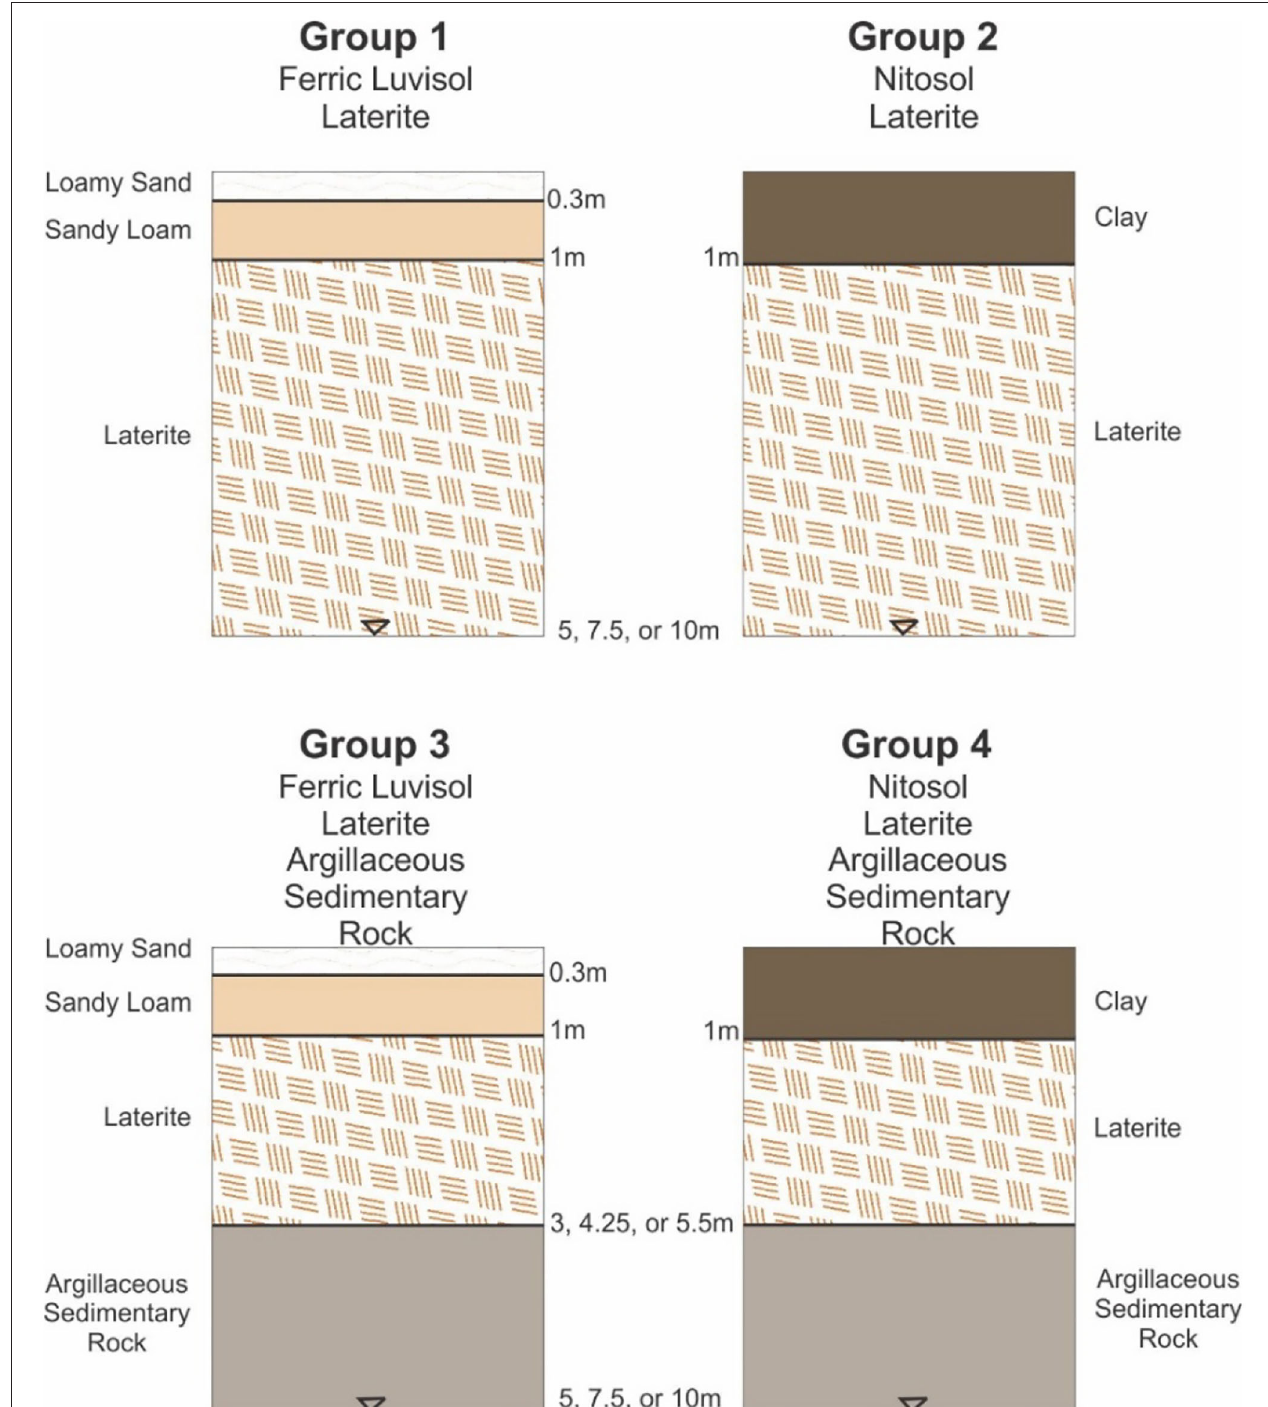
FIGURE 5 | Conceptual models of the four unsaturated zone columns at three depth intervals (5, 7, and 10m) thought to be most representative of the recharge environment of southern Mali based on the water levels and stratigraphy of the observation wells in the region.